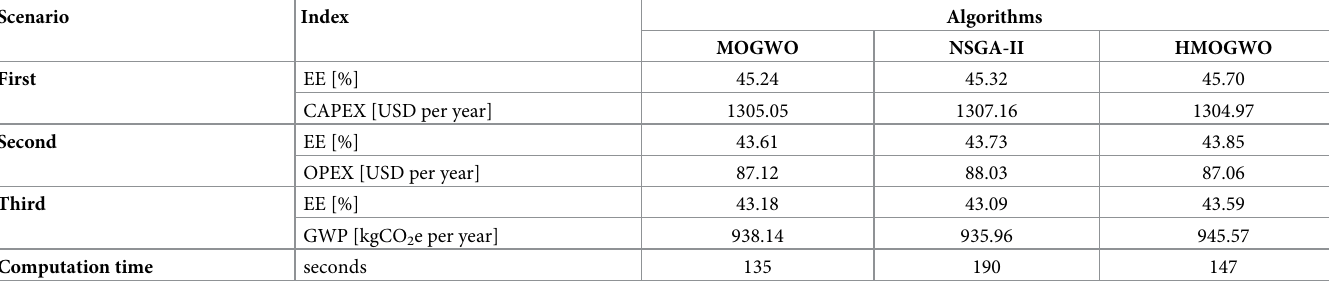
Table 10. Comparison of the optimum solutions obtained by MOGWO, NSGA-II, and